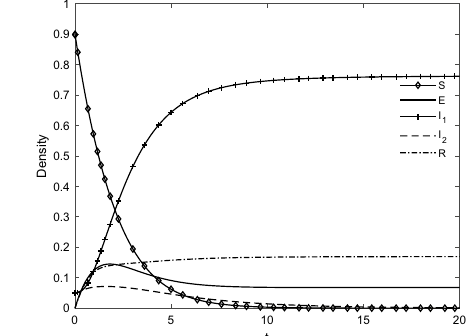
(b) The change curves of density of residents.